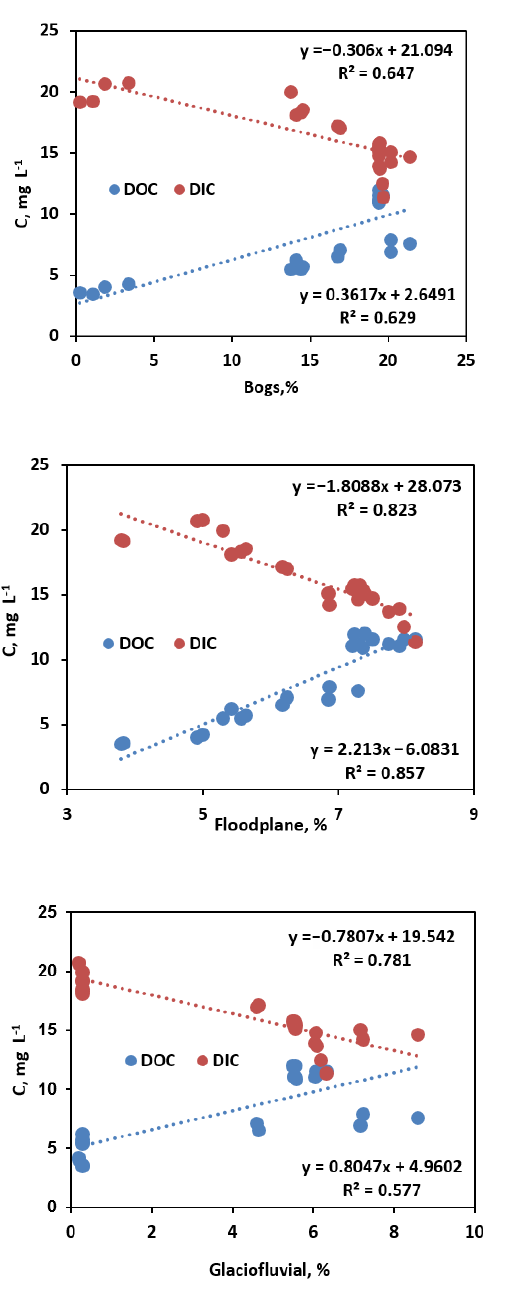
Figure 6. Examples of landscape factors, soil and Quaternary deposit control on the DOC and DIC concentrations in the Ob River. See examples of other factors and elements in Figure S5. A correlation matrix of environmental parameters of the watershed and riverine solutes is provided in Table S3.